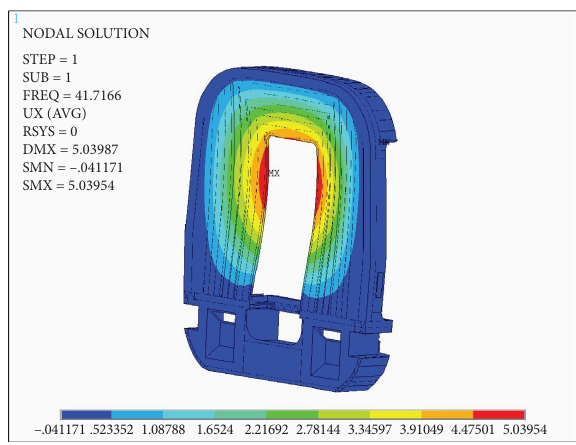
Figure 6: First-order natural frequency and mode shape of the car body end wall.